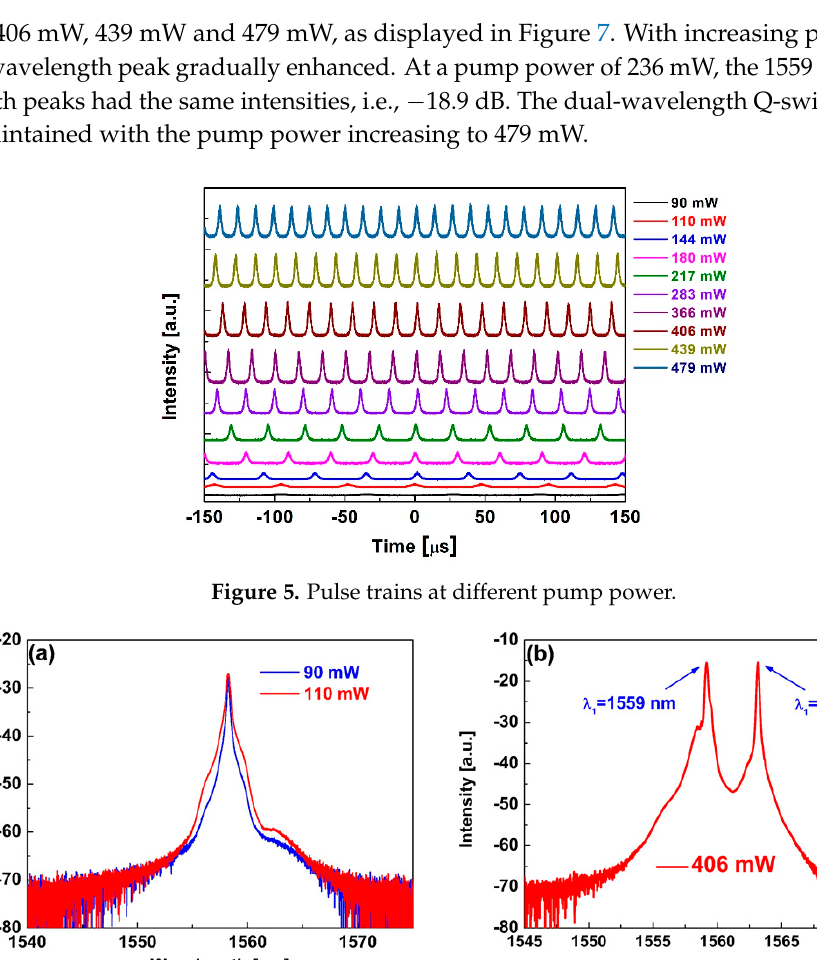
Figure 6. ( a ) Single wavelength radiation spectrum; ( b ) Dual-wavelength radiation spectrum.